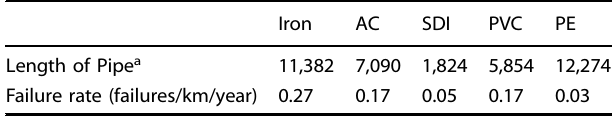
Table 3. WDN data collected between 2005 and 2018.